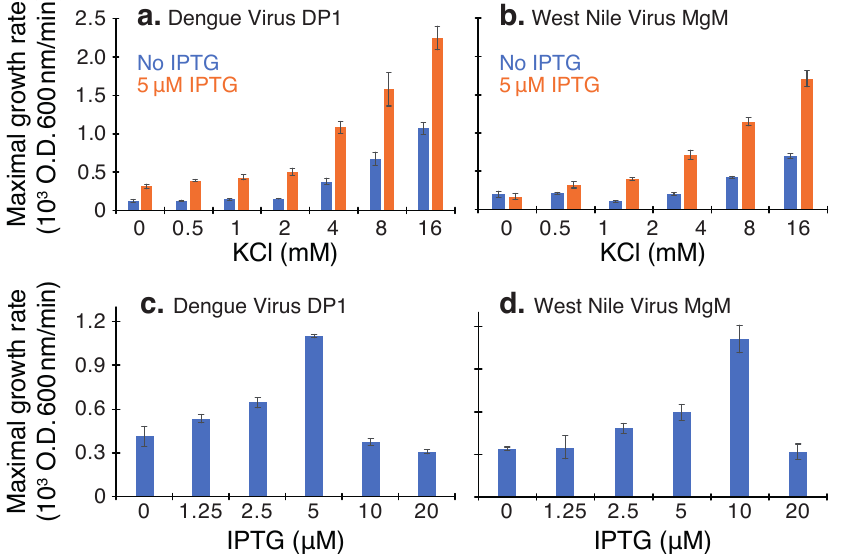
Figure 2. Positive assay of Dengue Virus DP1 and West Nile Virus MgM viroporins. Panels a and b: Maximal growth rates of K + -uptake deficient bacteria expressing each viroporin, monitored as a function of different K + concentrations. Growth enhancement can be observed upon comparing induced and uninduced bacteria in orange and blue, respectively. Panels c and d: growth rates at different inducer concentrations (IPTG), as noted.